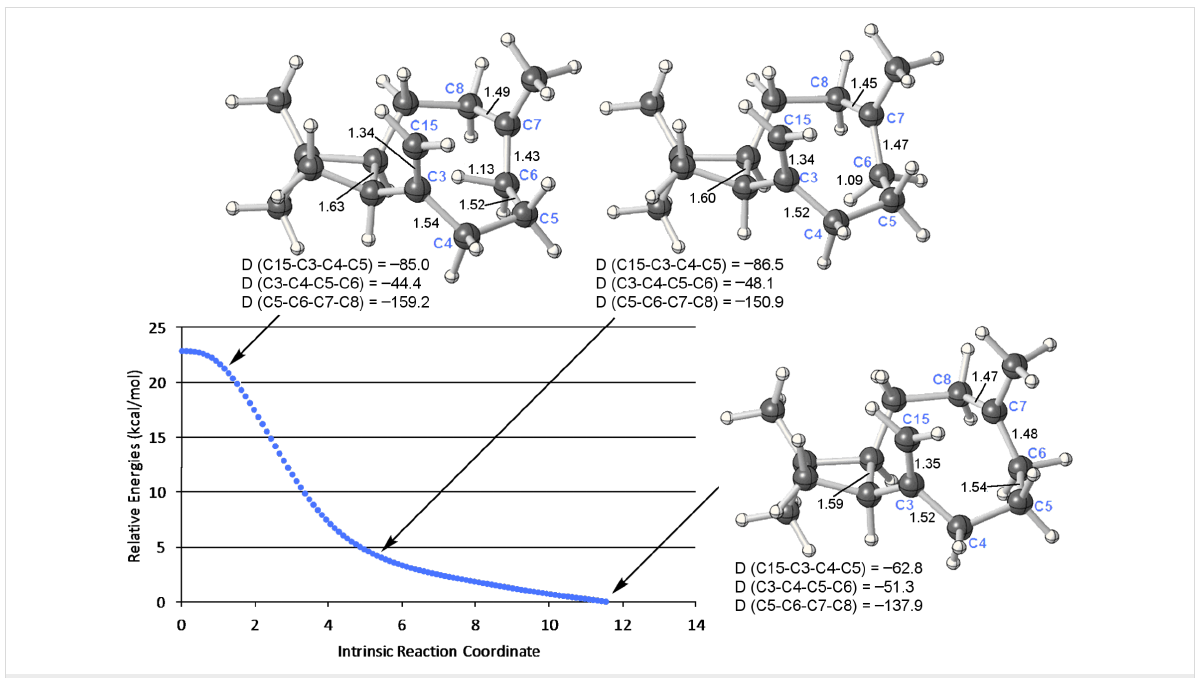
closer to the realm of proton sandwiches. TS-GE looks very similar, but with different longer and shorter H---C partial bonds and a longer H---C15 distance (2.71 Å, consistent with